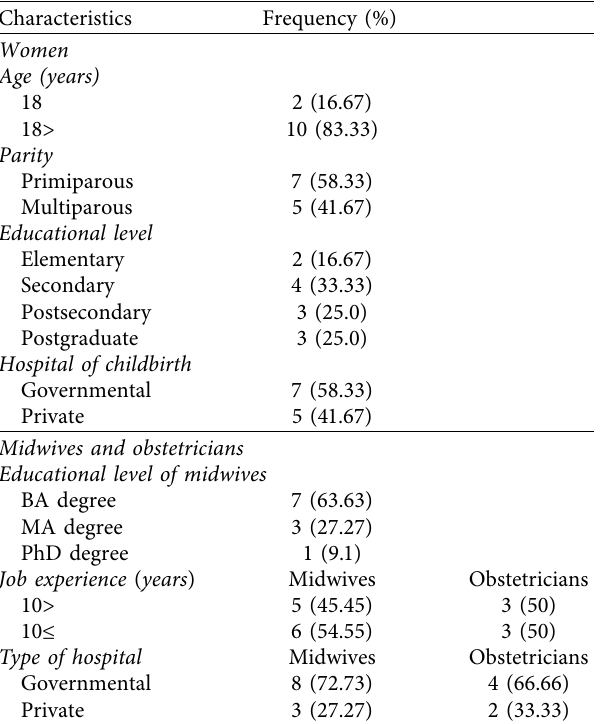
Table 1: Characteristics of the participants.